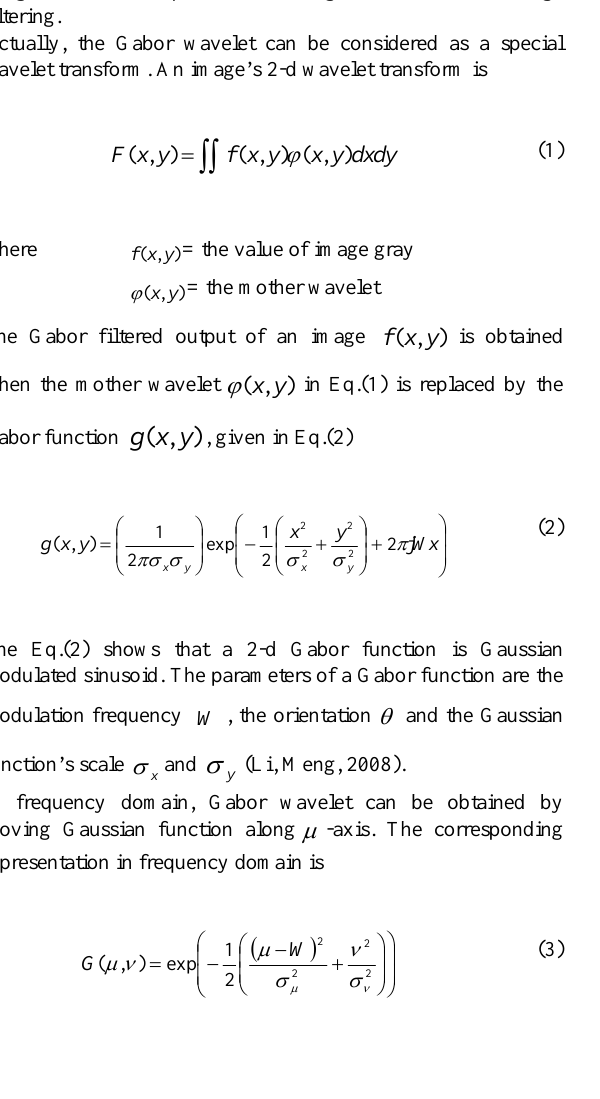
Figure 2. Textures of Lena with different πθ= to πθ= orientations(a to f stand the texture images of 6 with